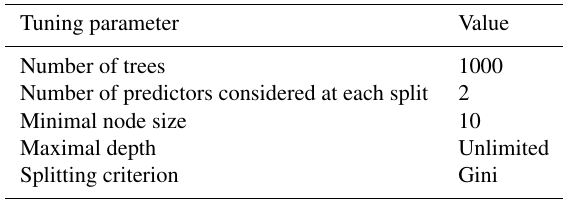
Table B1. Overview of the tuning parameters of the probabilistic